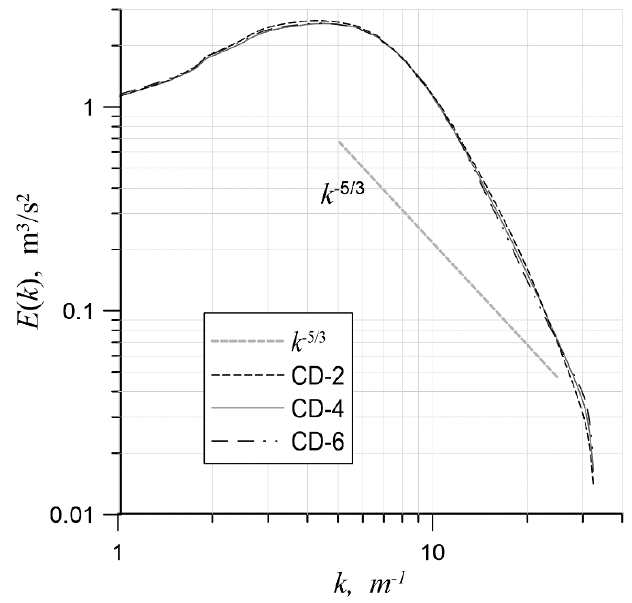
Figure 4. The energy spectrum for various central-difference approximations on a mesh with 64 3 cells and heun3; C DES 2 = 1.